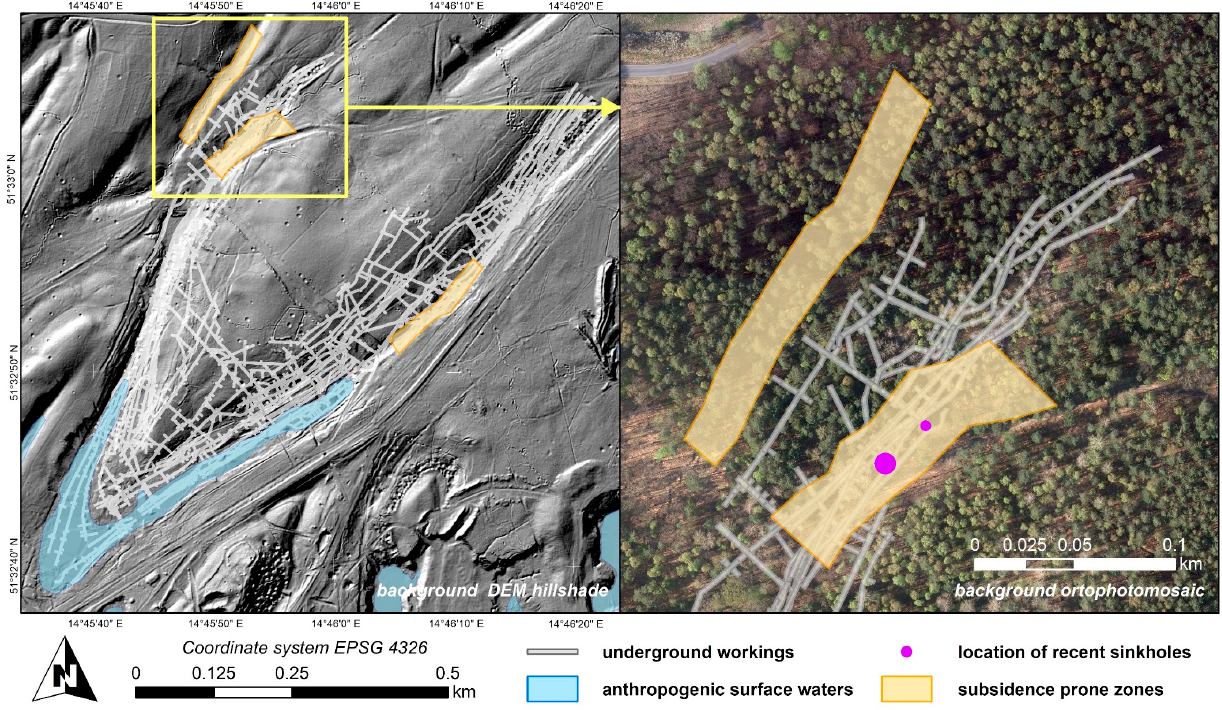
Figure 10. Interpreted subsidence risk areas in zones of ground disturbed by mining